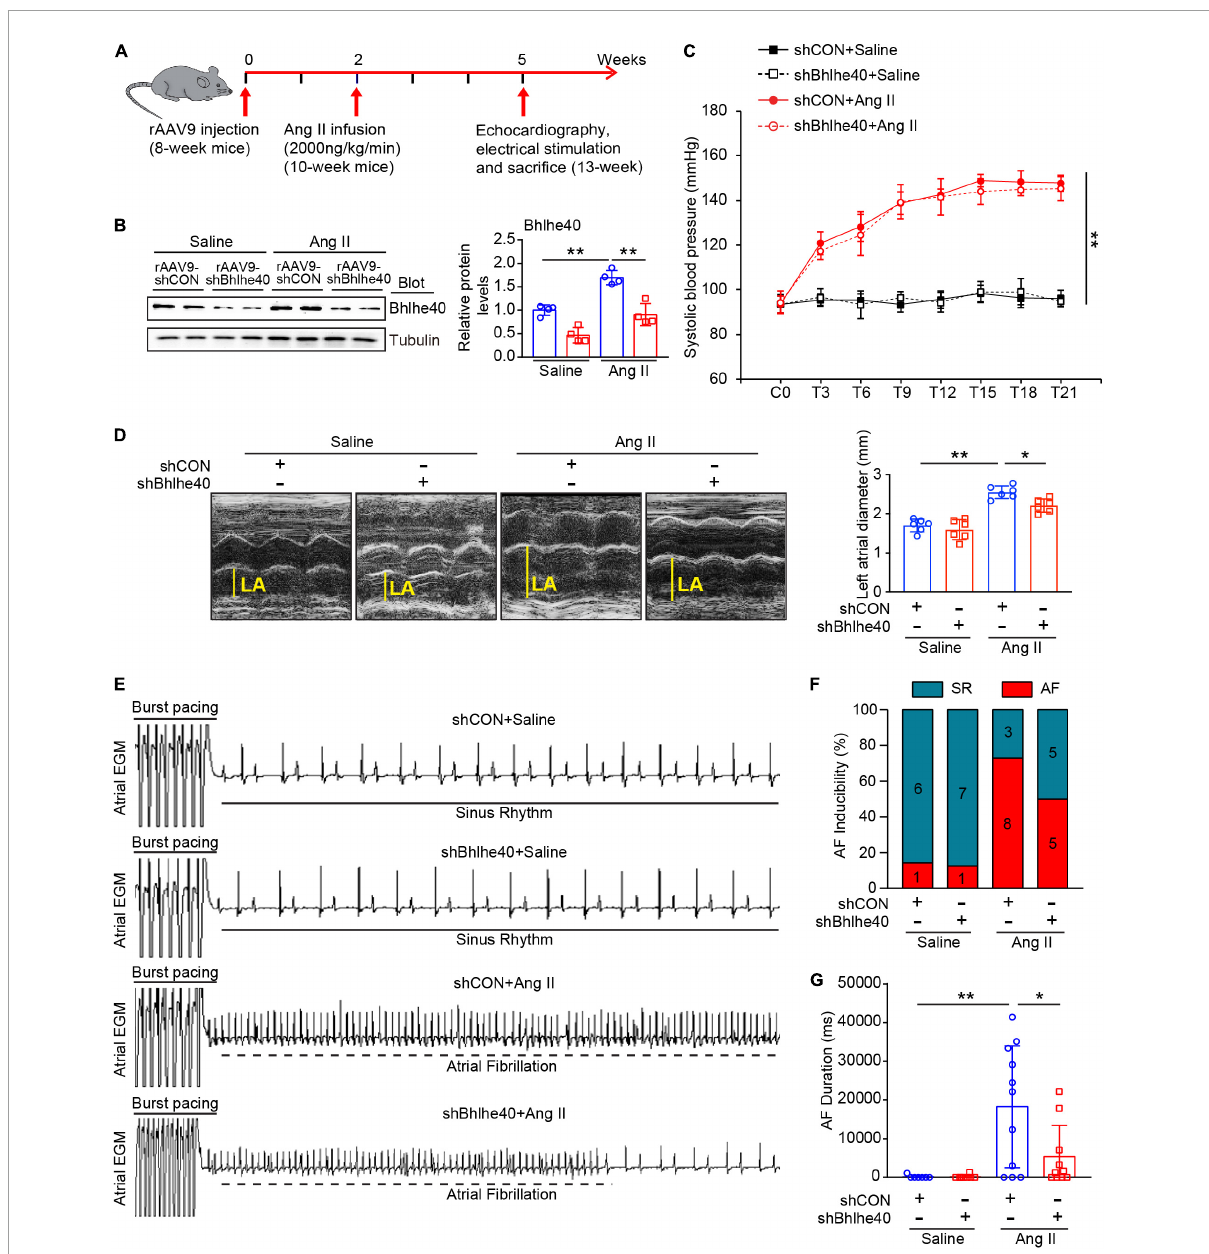
FIGURE3 Knockdown of Bhlhe40 by rAAV9-shBhlhe40 injection attenuates Ang II-induced atrial remodeling and AF in mice. (A) Protocol for injection of rAAV9 in mice of cardiac remodeling. Mice were injected with rAAV9-shBhlhe40 or rAAV9-shCON for 2 weeks and then treated with Ang II (2,000 ng/kg/min) infusion for additional 3 weeks. (B) Immunoblotting analysis of Bhlhe40 expression in mice injected with rAAV9s and infused with Ang II or saline (left). The quantification of the Bhlhe40 level (right, n = 4). (C) Systolic blood pressure (SBP) was measured by the tail-cuff method every 3 days after Ang II administration ( n = 6). (D) Echocardiographic measurement LA dilation (left) and the quantification (right) in Ang II or saline-infused mouse ( n = 6). (E) Representative atrial electrogram recordings for AF or SR control. The solid lines indicate burst pacing, and the dashed lines indicate AF. (F) Percentage of mice with AF in each group ( n = 7–11). (G) Total AF duration for each rAAV9-shCON-injected and rAAV9-shBhlhe40-injected mouse treated with Ang II or saline infusion. * P < 0.05, ** P < 0.01.